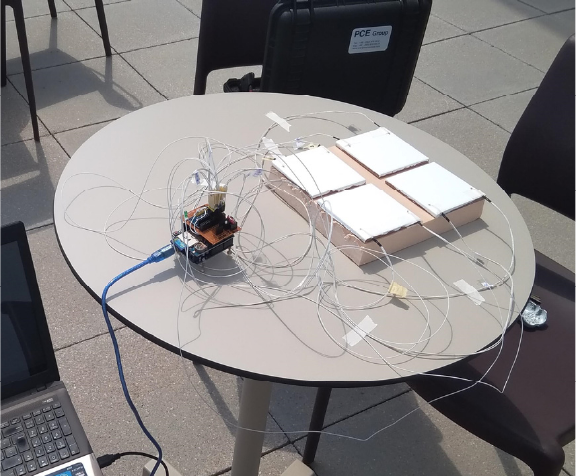
Figure 6. General view of the emissivity experimental set-up. Surface temperatures of the samples were measured with NTC 100K 3950 thermistors connected to an Arduino UNO board [45], previously calibrated for the expected temper- ature range (0 °C to 75 °C); two sensors were placed on each sample (Figures 6 and 7a). Simultaneously, thermographic photographs were taken with the thermographic camera PCE-TC 3 [52]. The technical specifications of these elements are detailed in Table 3.